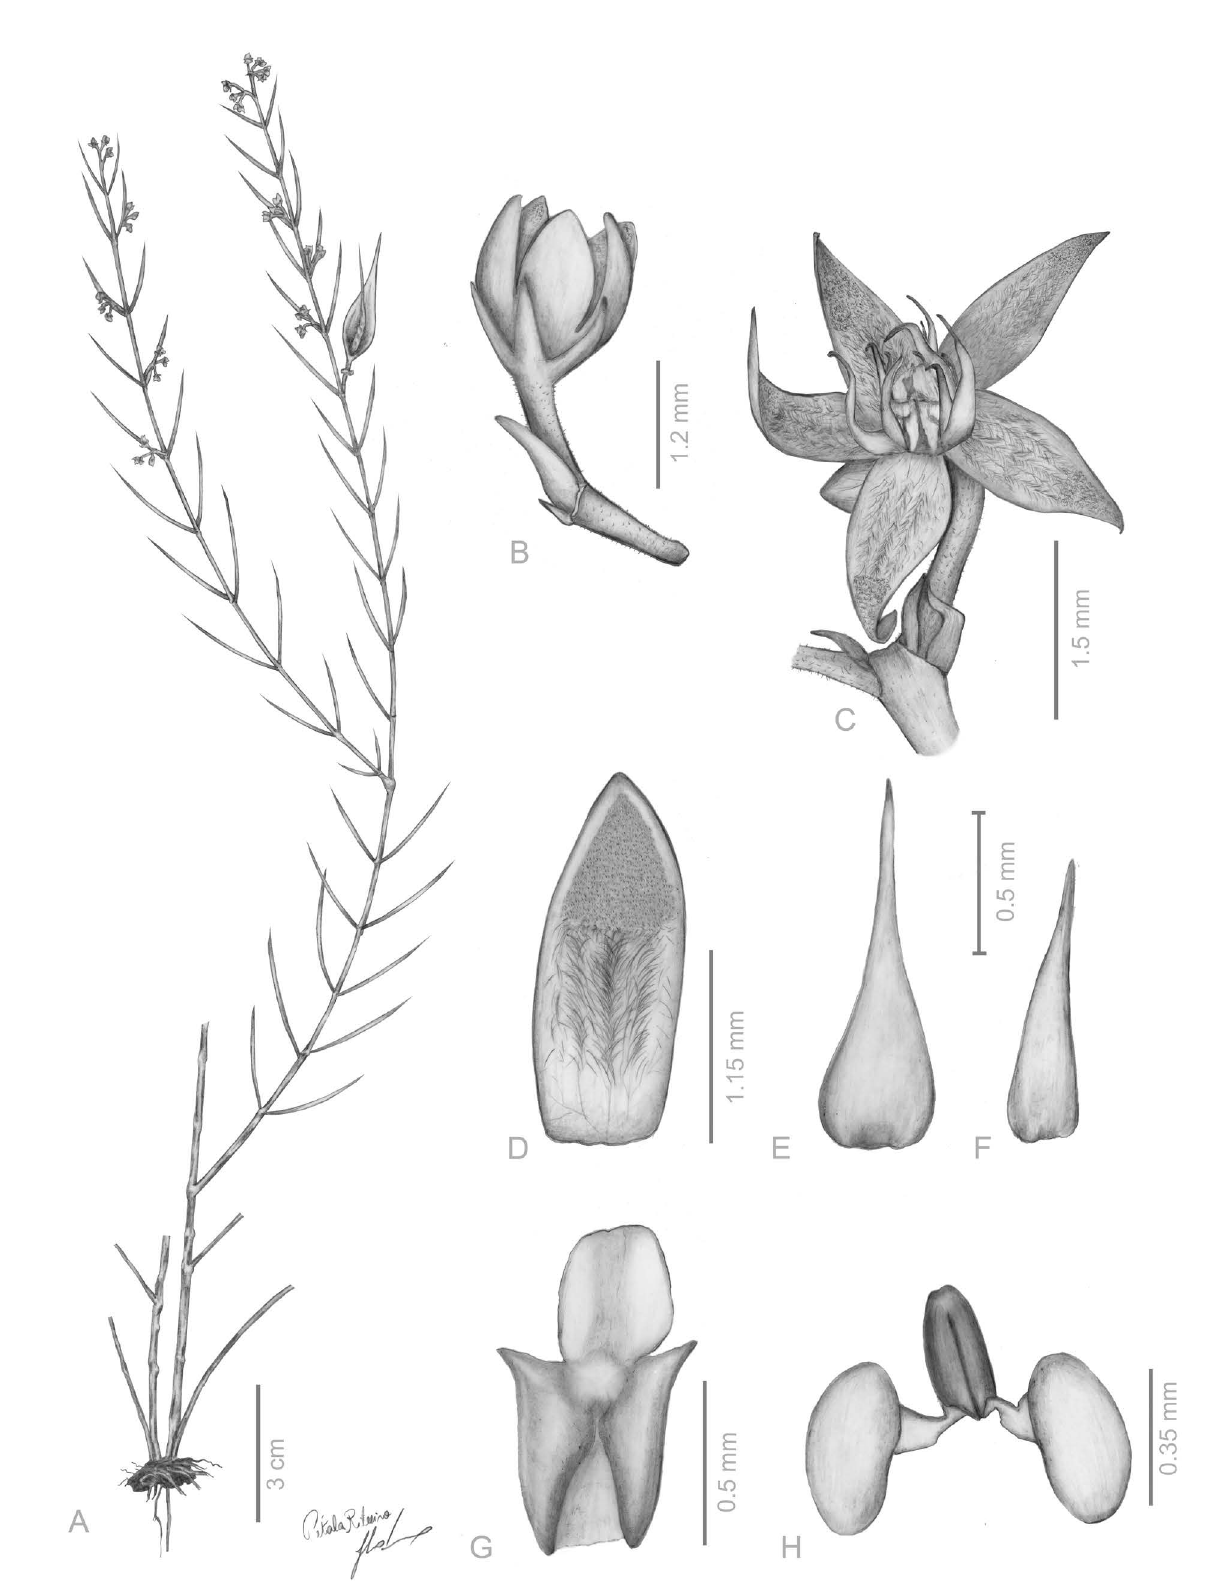
Figure 4 – Ditassa ferricola . A . Habit. B . Flower (lateral view). C . Flower, showing the gynostegium. D . Corolla lobe (adaxial view). E . Outer lobe of the corona (adaxial view). F . Inner lobe of the corona (adaxial view). G . Anther (abaxial view). H . Pollinarium. Illustration by Pétala Gomes Ribeiro from Carmo